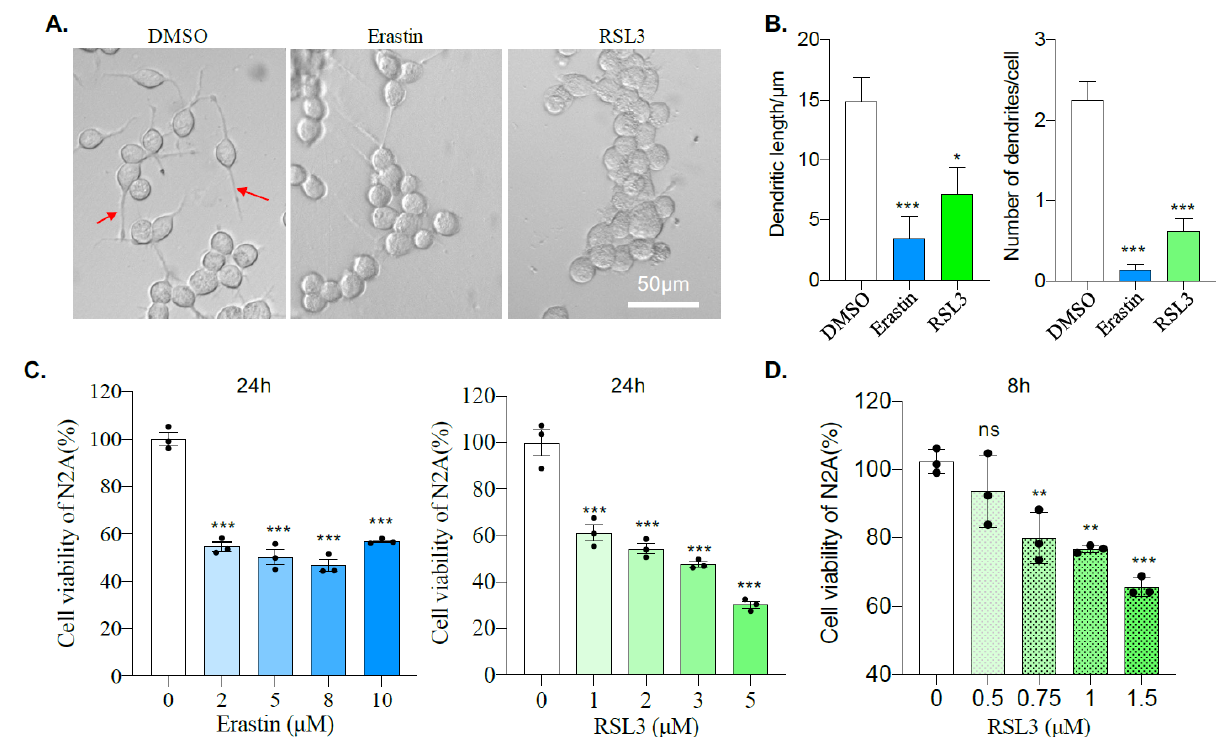
Figure 1. Erastin and RSL3 treatments affect the morphology and viability of N2A cells. ( A ) N2A cells were treated with DMSO, 10 μ M Erastin or 5 μ M RSL3, and bright-field images were taken 24 h after for morphology analysis. The red arrows indicate the dendrites. Scale bar = 50 μ m. ( B ) The total neurite length and the number of primary neurites per cell from ( A ) were analyzed. n = 20 from three repeated experiments. *: p < 0.05; ***: p < 0.001. Neurite length was measured by Image J. ( C ) The viability of N2A cells was analyzed by CCK-8 assay at 24 h after treating with DMSO, different doses of Erastin or RSL3. ( D ) The viability of N2A cells was analyzed by CCK-8 assay at 8 h after treating with DMSO, low doses of RSL3. Data were obtained from three independent experiments. **: p < 0.01; ***: p < 0.001; ns: not significant.